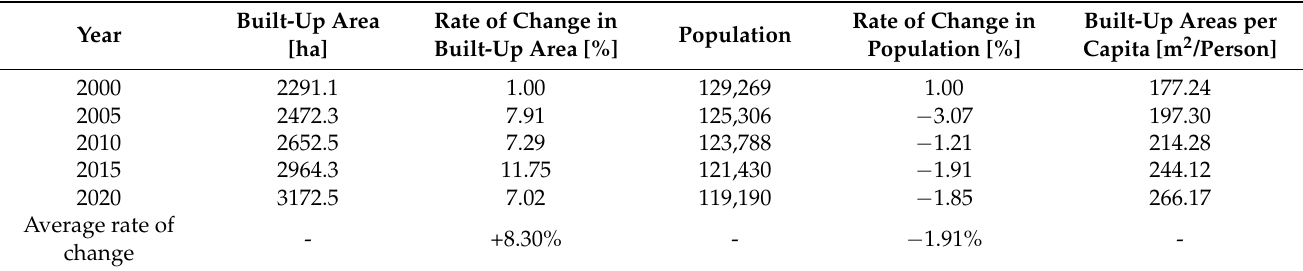
Table 7. The rate of change in the growth of built-up areas in relation to the population in Opole between